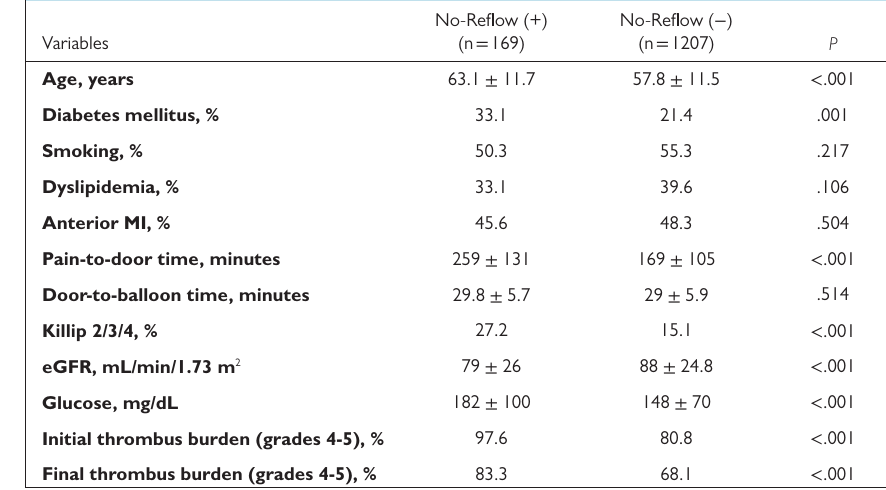
Table 3. Comparison of Clinical and Angiographic Features Between Groups With and Without No-Reflow